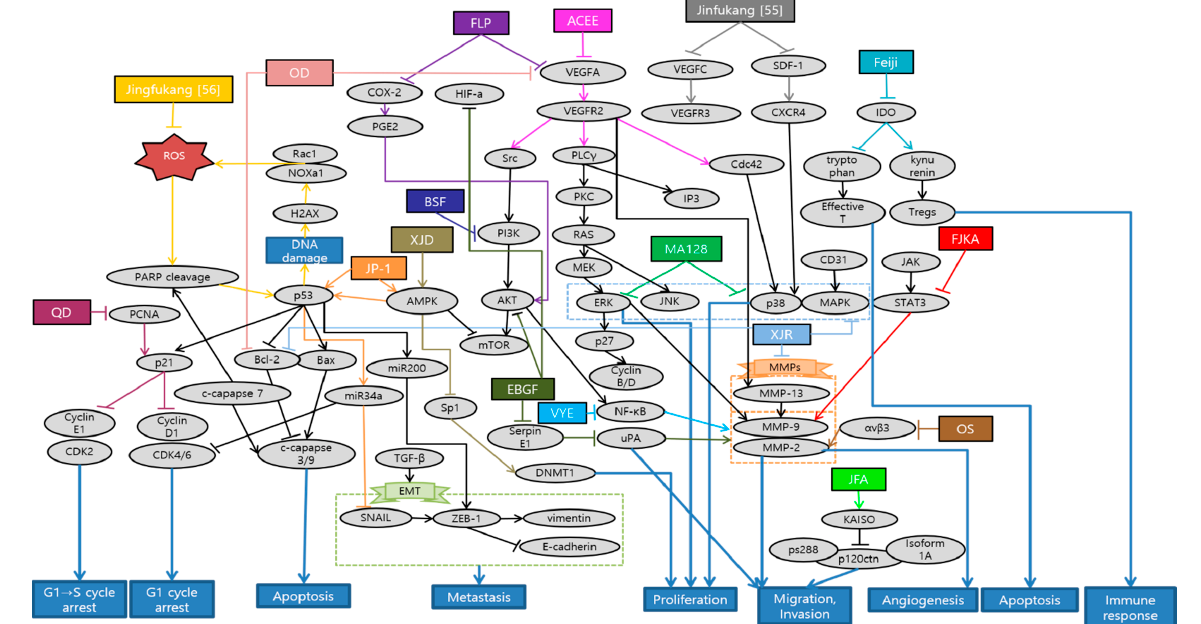
Figure 1. Schematic diagram of anti-metastatic mechanisms of herbal medicine in lung cancer: Herbal medicine can suppress angiogenesis, metastasis and proliferation by inactivating sequential cascades below such as epithelial mesenchymal transition (EMT) and matrix metallopeptidases (MMPs). Vascular endothelial growth factor A (VEGFA) and VEGF receptor 2 (VEGFR2) signaling activate the downstream pathways such as phospholipase C gamma (PLC γ ), focal adhesion kinase (FAK), Src and protein kinase B (AKT). Cyclooxygenase 2 (COX2) and prostaglandin E2 (PGE-2) can also activate AKT, which generally begins from phosphoinositide-3-kinase (PI3K). This activates nuclear factor kappa B cells (NF- κ B) affecting MMPs and EMT processes, which are the basic steps for metastasis. In the process of EMT, Snail activates zinc finger E-box-binding homeobox-1 (ZEB-1), vimentin, N-cadherin, while down-regulating epithelial cadherin (E-cadherin). On the other hand, ERK/p38/MAPK pathway which is activated from various factors such as C-X-C chemokine receptor type 4 (CXCR4), cluster of differentiation 31 (CD31), electron transport chain (ETC), also induces MMPs. Furthermore, natural antioxidants can affect reactive oxygen species (ROS)-induced cascades, promoting apoptosis, cell cycle arrest and some metastatic changes. As a reaction to DNA damage from oxidative stress, poly (ADP-ribose) polymerase 1 (PARP1) is cleaved and regulates the stability of p53. DNA damage by ROS also mediates ataxia telangiectasia mutated (ATM)/ATM and Rad3-related (ATR)-p53 signaling pathway. P53 affects B-cell lymphoma (Bcl) and Bcl-2 associated X protein (Bax) which leads to caspase 3/9 cleavage for apoptosis. Additionally, p53 activates p21 expression which is highly related to cell cycle arrest, especially G1 phase. P53/miR34a axis is proposed to induce cell cycle arrest and suppress some of the EMT process. Herbal medicine can also stimulate T cell apoptosis and suppress Tregs immune function by inhibiting indoleamine-2,3-dioxygenase (IDO) expression. Abbreviation: ACEE, Antrodia cinnamomea ethanol extract; EBGF, ethanol extract of baked Gardeniae Fructus; OS, Ocimum sanctum ; VYE, Viola Yedoensis extract; BSF, BushenShugan Formula; FLP, Fei-Liu-Ping; FZKA, Fuzheng Kang-Ai; JFA, Jinfu’an; QD, Qingzaojiufei decoction; XJR, Xiaoai Jiedu Recipe; XJD, Xiaoji